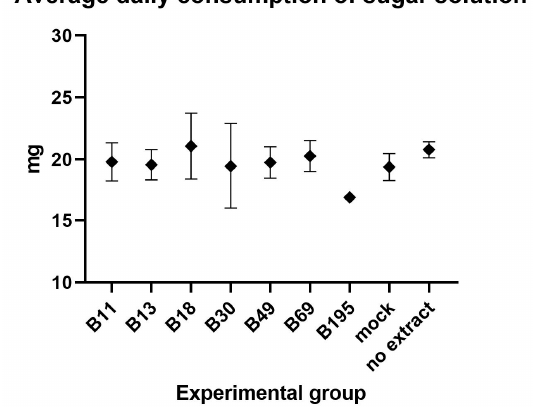
Figure 2. The average daily consumption (mg/bee) of 1:1 (w/v) of sugar solution enriched with the fungal crude extracts, the extraction solvent (80% acetone) in the mock group, or no extract, before the injection of CBPV.